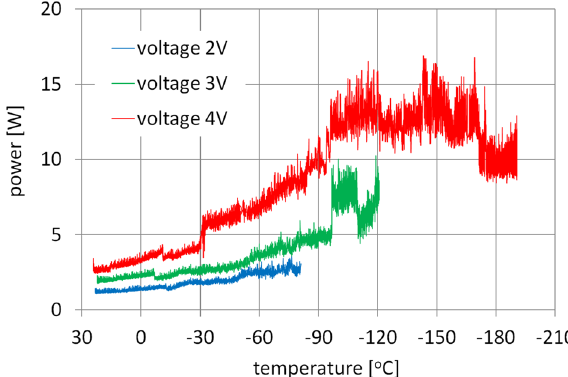
Figure 12. Initial measurements of the gearset power